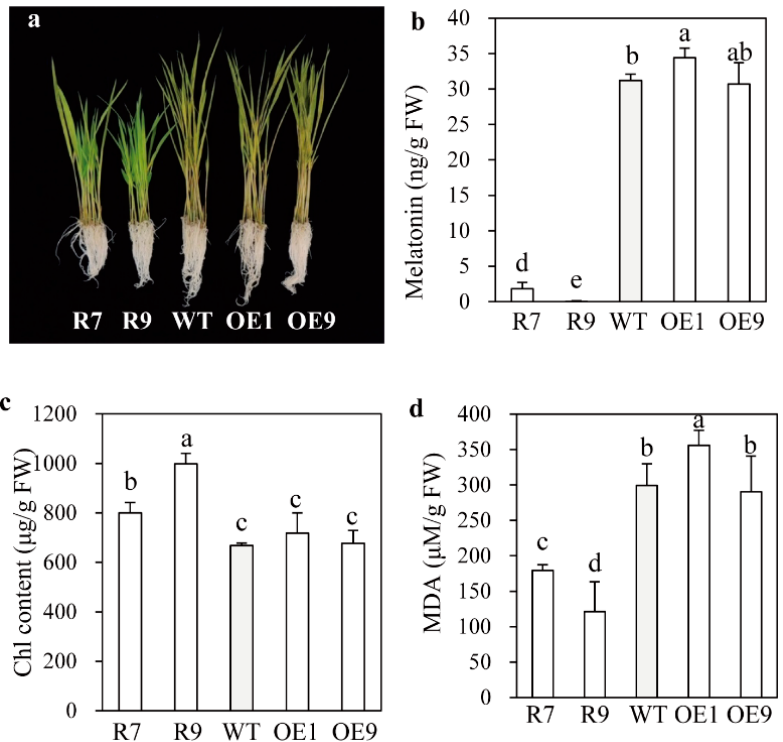
Figure 5. E ff ects of cadmium treatment on melatonin, chlorophyll, and malondialdehyde (MDA) Figure 5. Effects of cadmium treatment on melatonin, chlorophyll, and malondialdehyde (MDA) levels in rice. ( a ) Rice seedlings after cadmium treatment. ( b ) Melatonin levels. ( c ) Chlorophyll